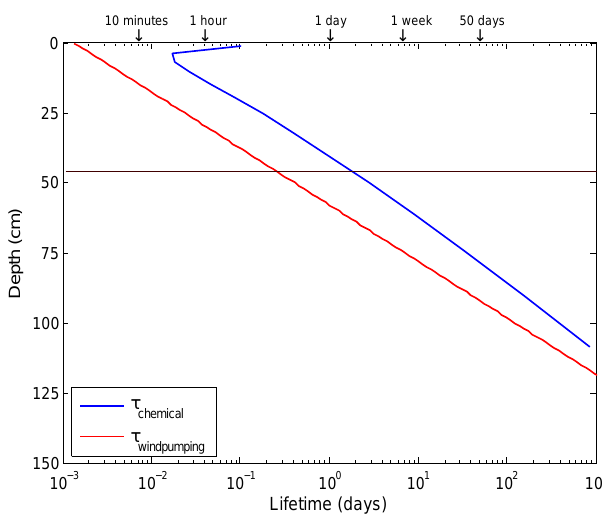
Fig. 5. Vertical profiles of τ wind pumping (red) and τ chemical (blue) in snow near the station at Summit. The profiles are calculated us- ing typical Summit sastrugi and meterological information (Table 3) and Summit chemical profiles calculated in Thomas et al. (2011) (Fig. 4). The e-folding depth in near-station snow at Summit is not calculated in this study because C BC and nonBC absorption are unknown. Three times the e-folding depth of actinic flux at λ = 305nm (3 z e ) for remote Summit snow is shown for reference (horizontal, black solid line), although 3 z e in near station snow is likely more shallow due to enhanced impurity concentrations from local station